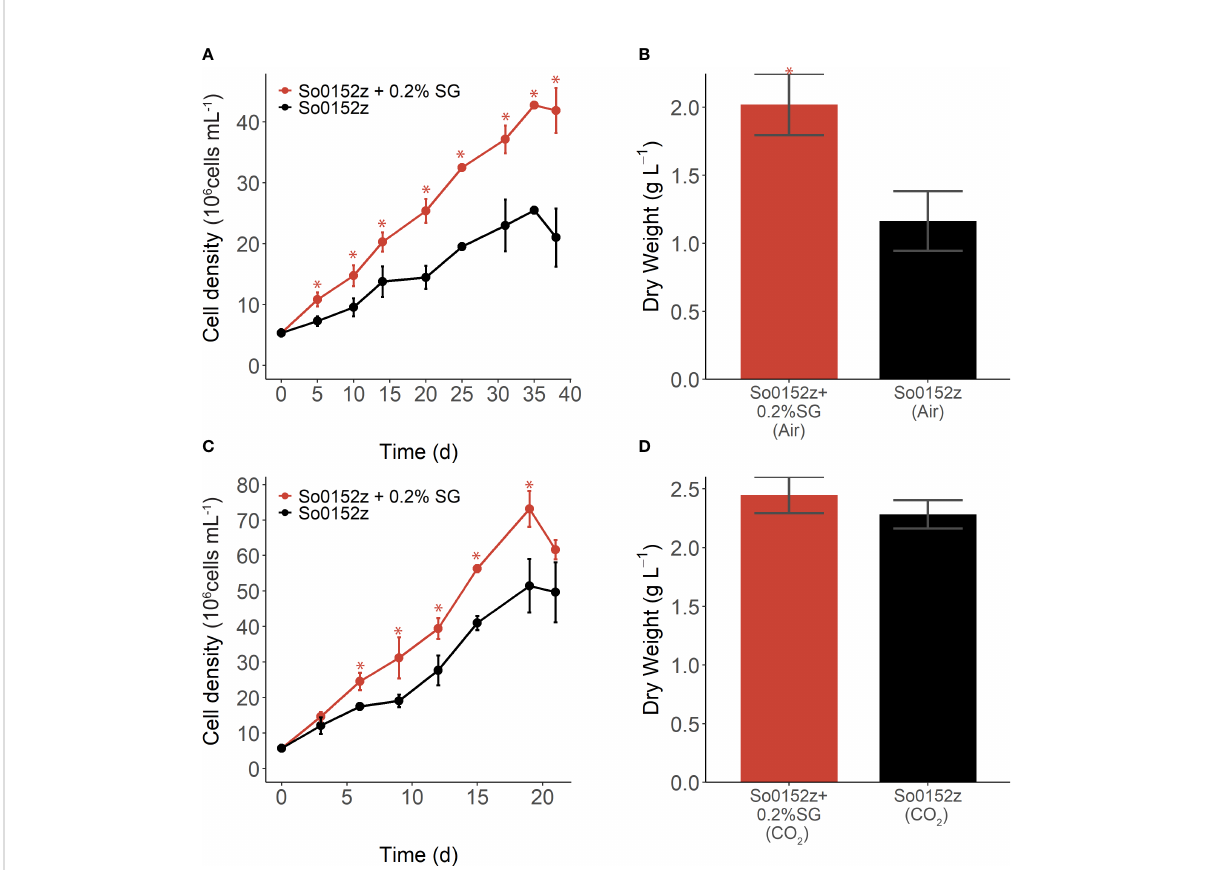
FIGURE 4 (A) Growth and (B) dry weight of S. obliquus with and without addition of 0.2% w/v switchgrass (SG) grown in air (i.e. ambient CO2). (C) Growth and (D) dry weight of S. obliquus with and without addition of 0.2% w/v switchgrass (SG), grown in l% CO2. Points and error bars indicate mean and standard deviation of three biological replicates. Stars indicate cell density or dry weight of S. obliquus with SG is signi fi cantly different from that of the alga alone (p-value < 0.05).